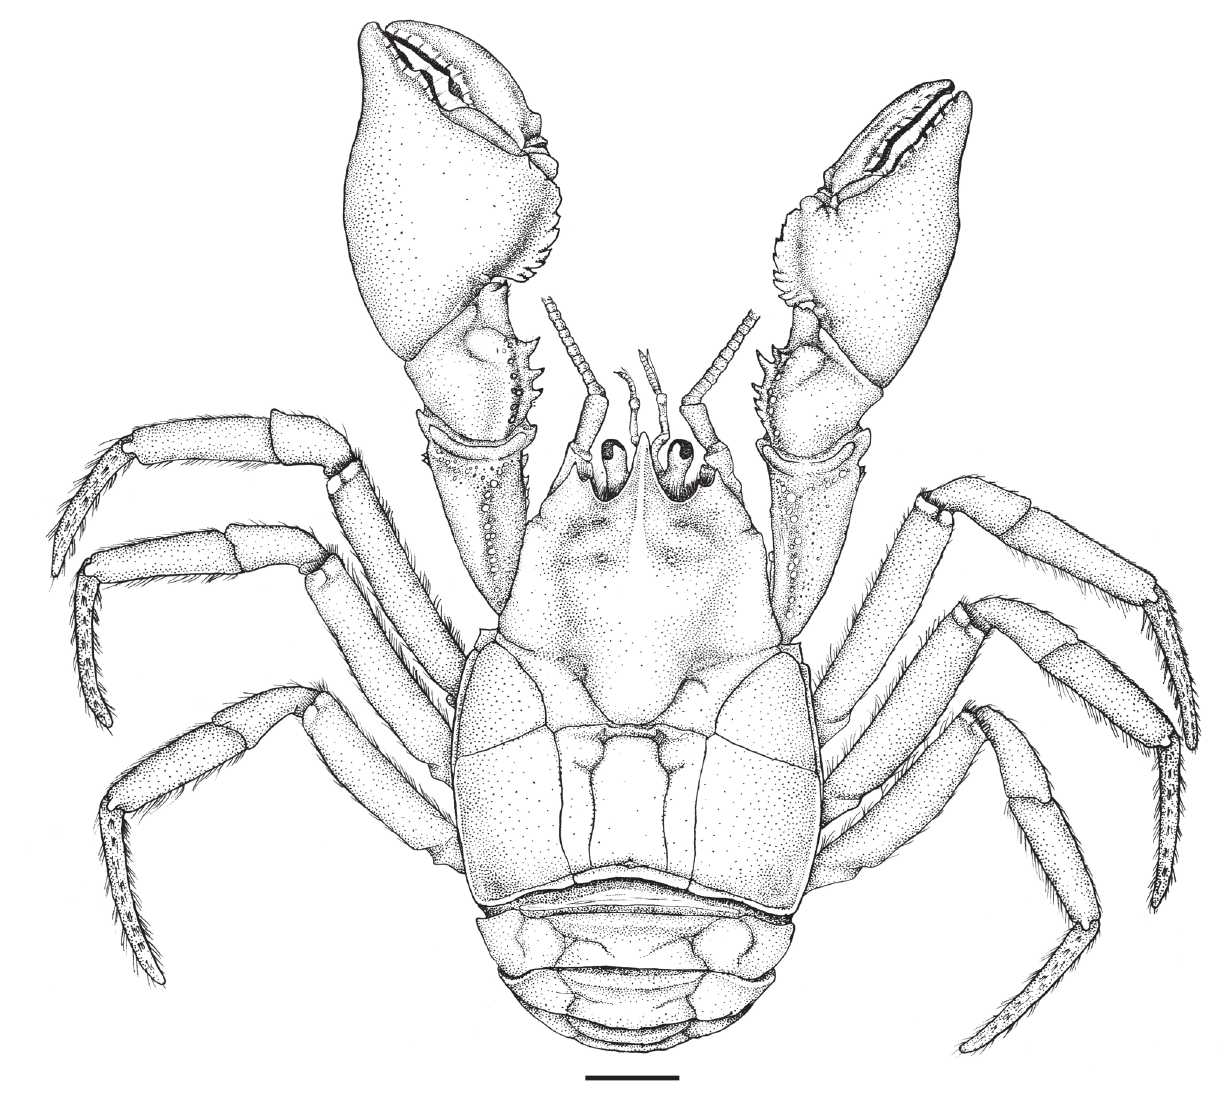
Figure 6. Aegla charon n. sp., male, holotype (CL 20.40 mm; CLR 23.91 mm) (MZUSP 35193), dorsal view. Scale bar = 5.0